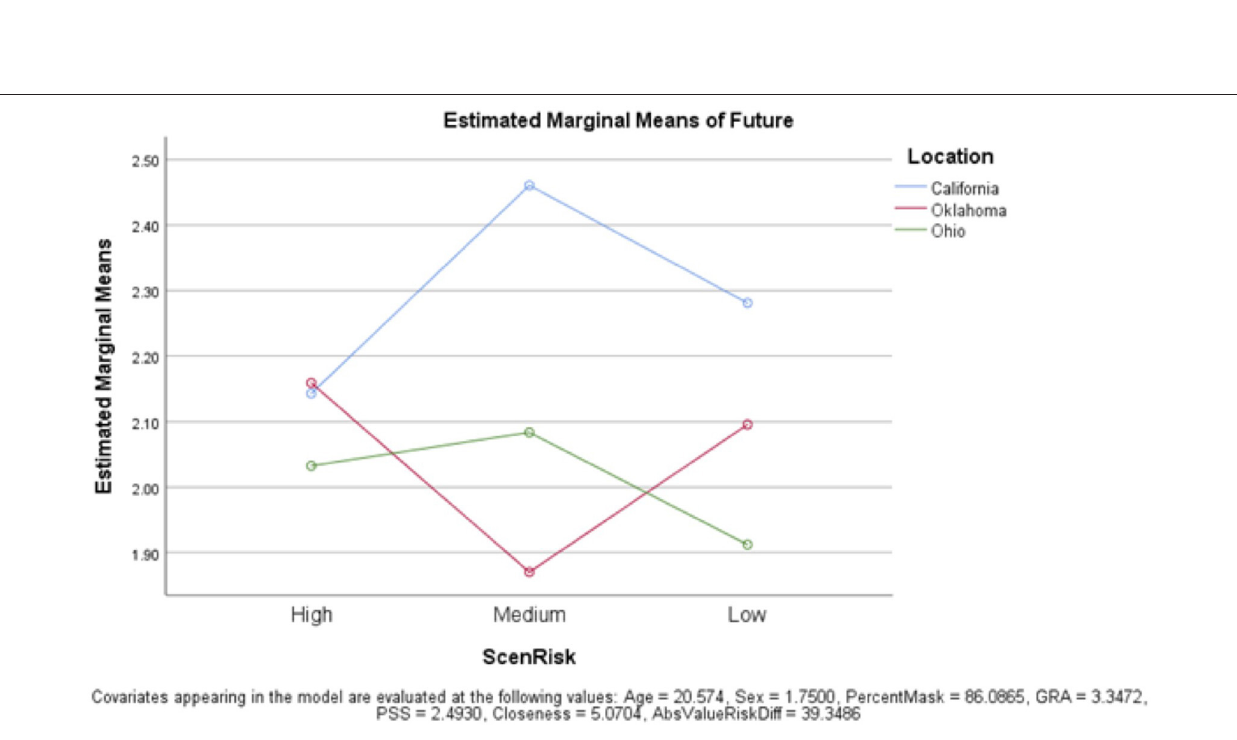
Frontiers in Communication |